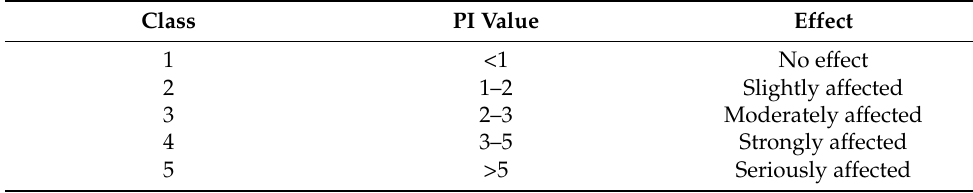
Table 4. Pollution levels as determined by PI according to Edet and Offong [48].